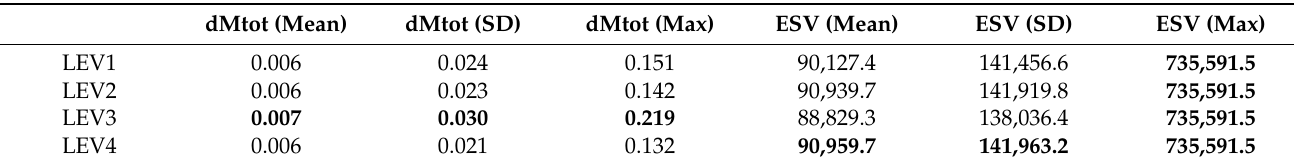
Table 2. Land cover aggregation scenario comparison: descriptive statistics. Bold numbers represent maximum values.